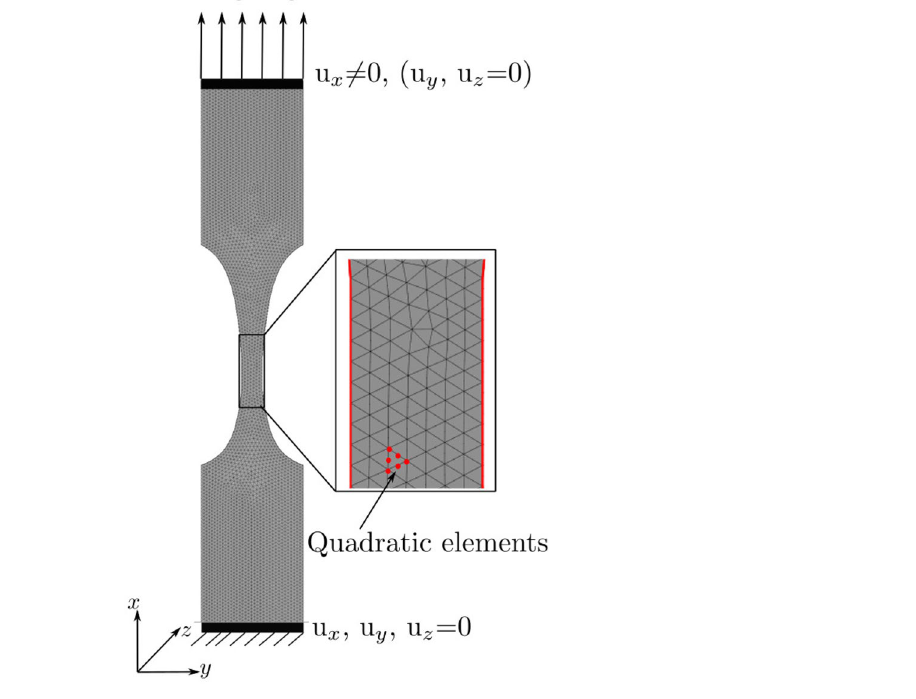
Figure 2. FE model including boundary conditions and mesh. The displacement was applied on the top of the specimen, while the bottom was constrained to mimic the experimental conditions. No material parameters (Elastic modulus) were assigned to the specimens because only strains were calculated and the FE simulation is displacement control. A poisson’s ratio of 0.3 was assigned for all specimens.